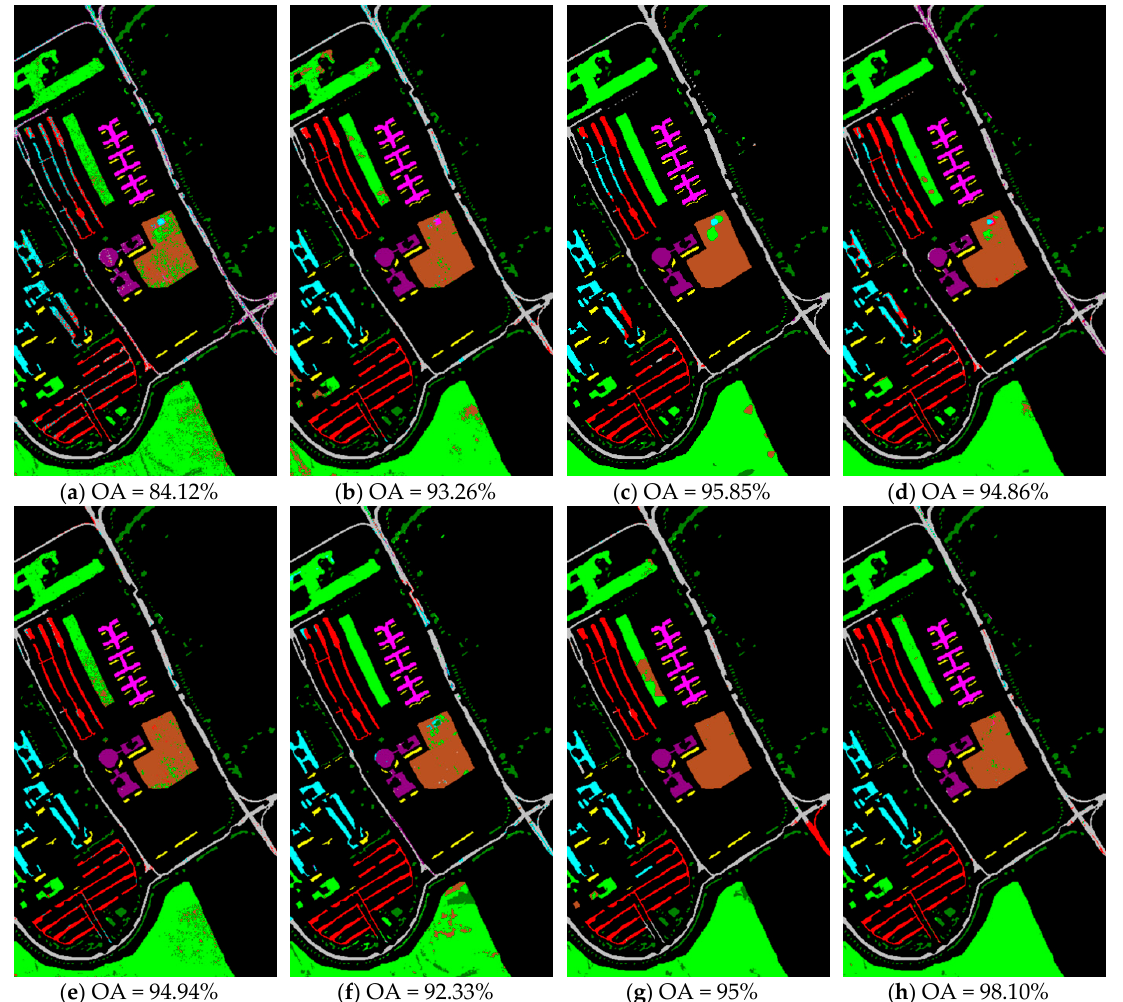
Figure 5. Classification results of the UP image. ( a ) SVM; ( b ) EMP; ( c ) EPF; ( d ) SVM-CK; ( e ) MLR-GCK; ( f ) SC-SSK; ( g ) SC-MK; and, ( h ) SVM-SSHK.